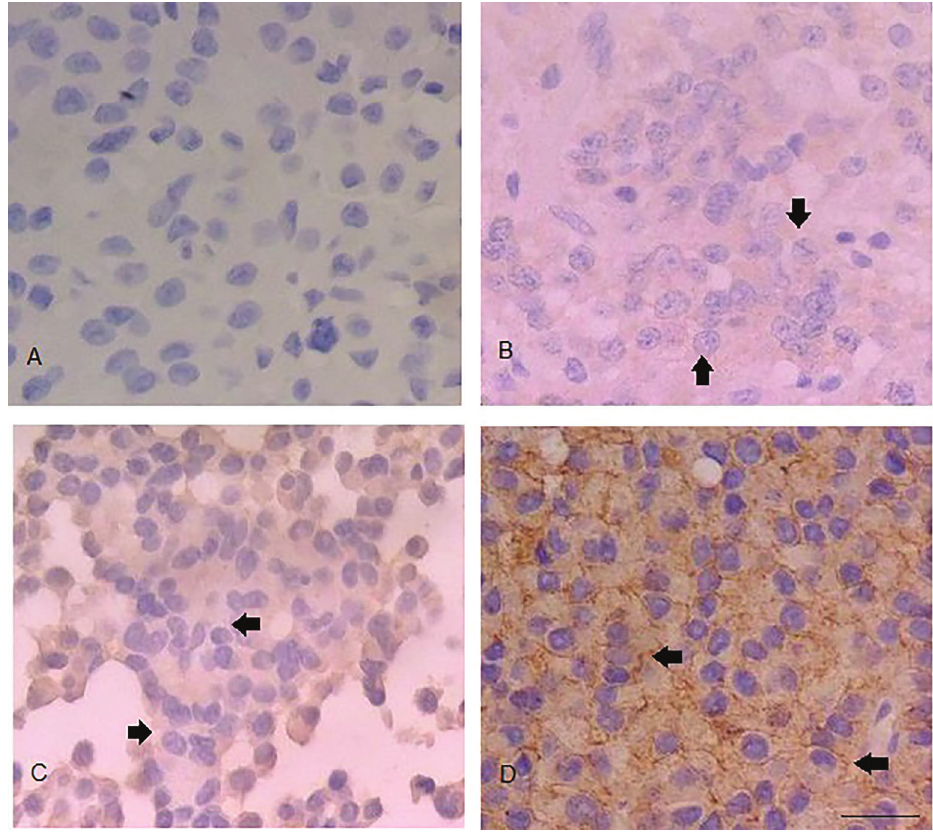
Figure 1. Immunohistochemical expression of ECAD (400 (cid:3) ). A , Negative expression ( (cid:1) ). B , Weak expression ( + ) ( fi nal score: 3). C , Moderate expression ( ++ ) ( fi nal score: 6). D , Strong expression ( +++ ) ( fi nal score: 12). All represent invasive tumors. Arrows indicate immunopositivity in the plasma membrane. Bar=200 m m for all Table 1. Immunohistochemical expression of ECAD and NCAM according to tumor grade and invasiveness based on preoperative images. Grade n=30